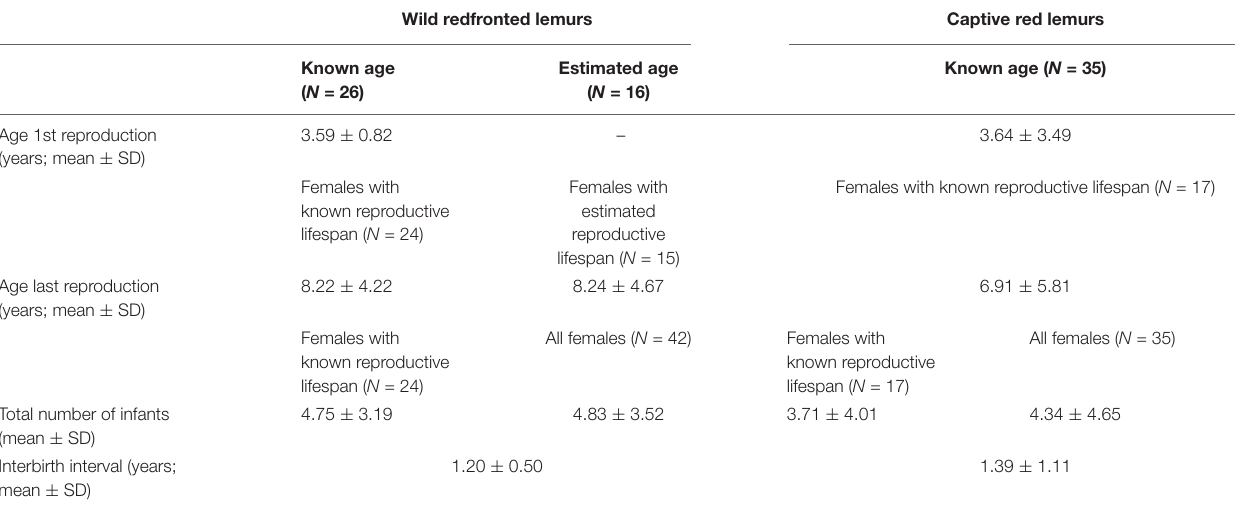
TABLE 4 | Overview of life-history milestones and sample sizes of wild redfronted lemurs and captive red